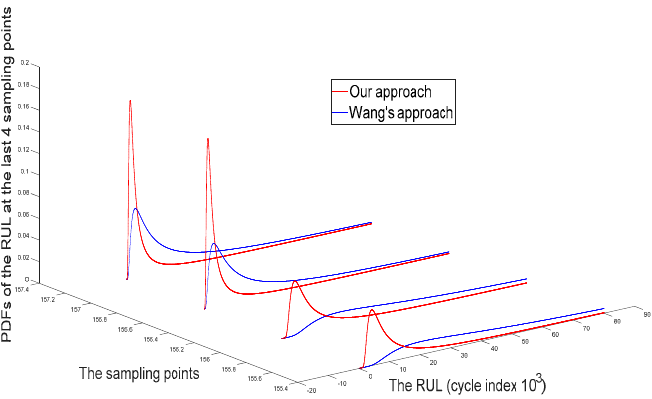
Figure 10. The PDF of the remaining useful life (RUL) at the last four different monitoring points.